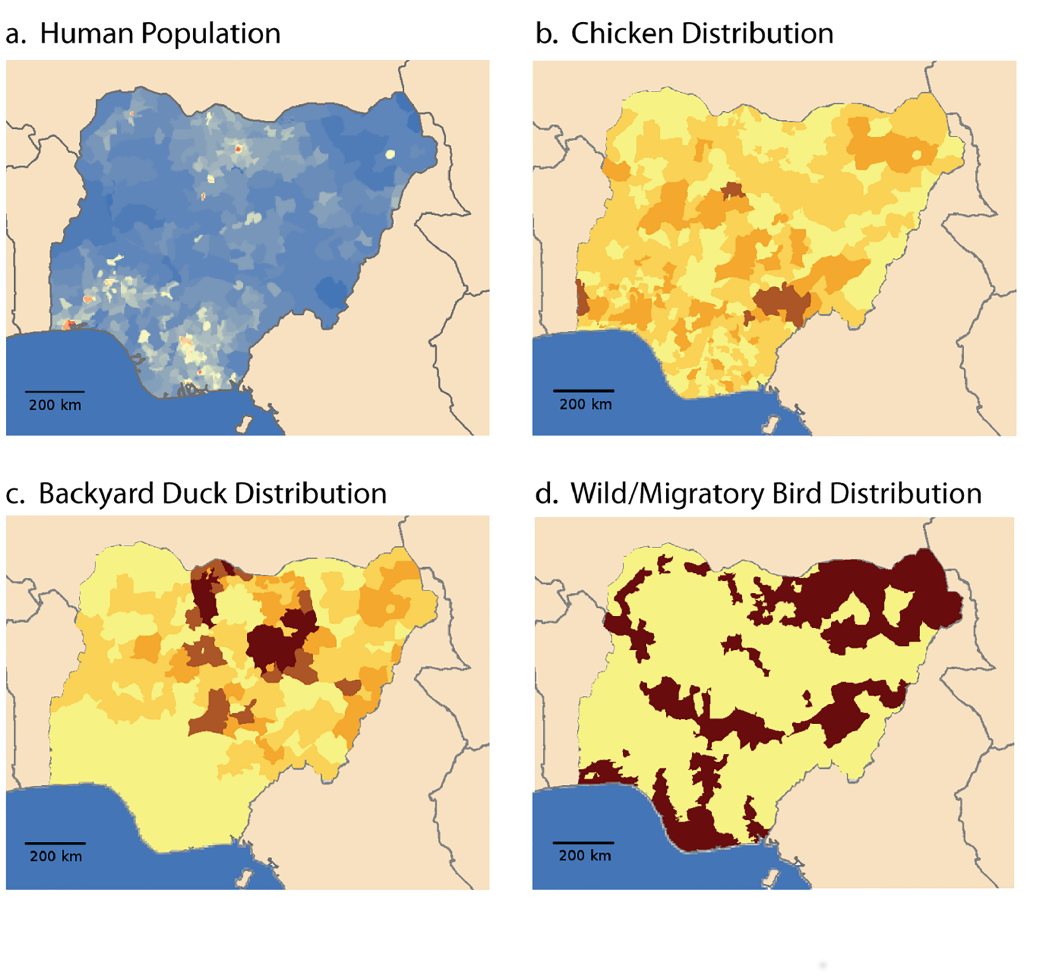
Fig 1. Shown are the distribution of the population of people (a), Chickens (b), backyard ducks (c) and migratory birds (d) used in these simulations. Colors are relative and intended to illustrate the population distribution for specific species, with darker indicating greater numbers. The human population is shown progressing from blue to red, with red indicating greater numbers. Data was gathered largely from United Nations sources and was processed to allow association with specific Nigerian local government associations (LGAs).